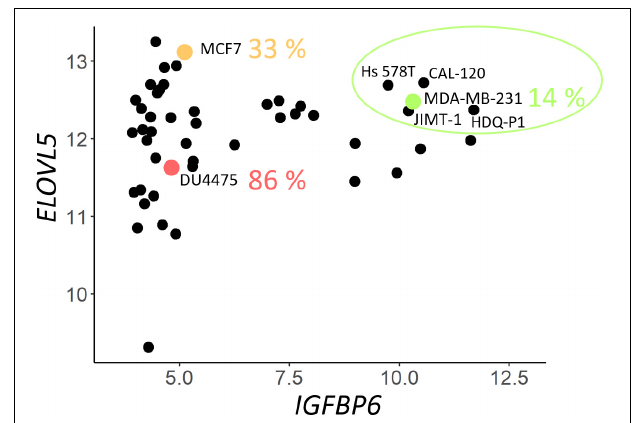
FIGURE 1 | Expression (on the Affymetrix logarithmic scale) of the ELOVL5 and IGFBP6 genes in breast cancer cell lines [according to Cancer Cell Line Encyclopedia (CCLE) data (Barretina et al., 2012)]. The proportion of cases when some of the cell lines form metastases to lungs in vivo (immunodeficient mice) is indicated according to Valentiner et al. (2005).